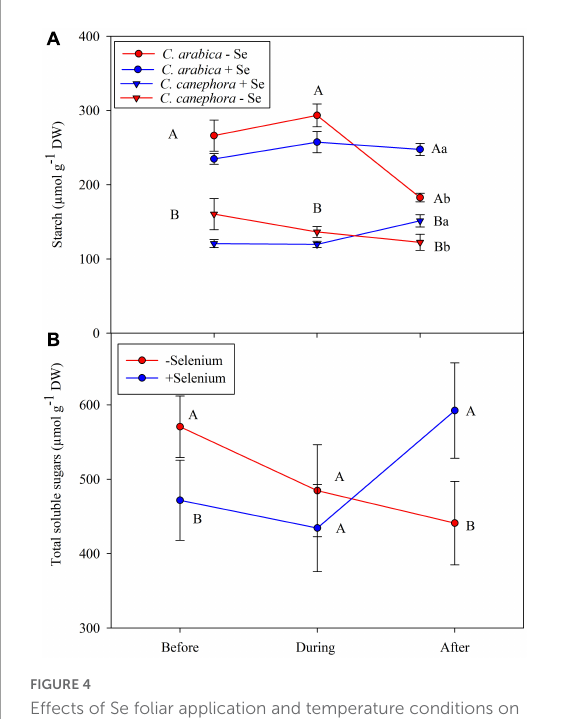
relationship between CAT and Se content was not